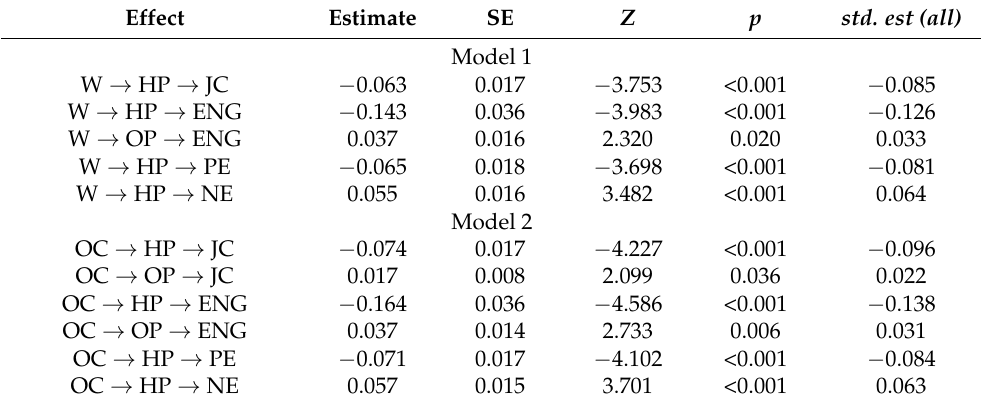
Table 2. Detailed results for indirect effects in the relationship between workload and organizational constraints and well-being indicators—job crafting, engagement, positive and negative emotions, considering the mediation of harmonious and obsessive passion, in subsequent models (1, 2). Effect Estimate SE Z p std. est (all) Model 1 W → HP → JC − 0.063 0.017 − 3.753 <0.001 − 0.085 W → HP → ENG − 0.143 0.036 − 3.983 <0.001